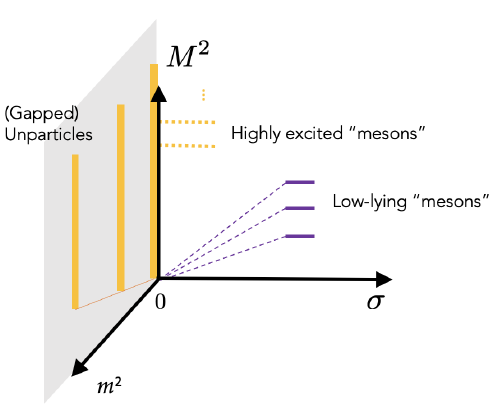
Figure 1. Schematic representation of the mass spectrum generated by the model defined by Equa- tions (46) and (49). The behaviours of states with fixed n (purple lines) and with fixed σ n (dotted orange lines) are represented in the m = 0 plane. The spectrum of gapped unparticles is represented in the σ = 0 plane (solid orange